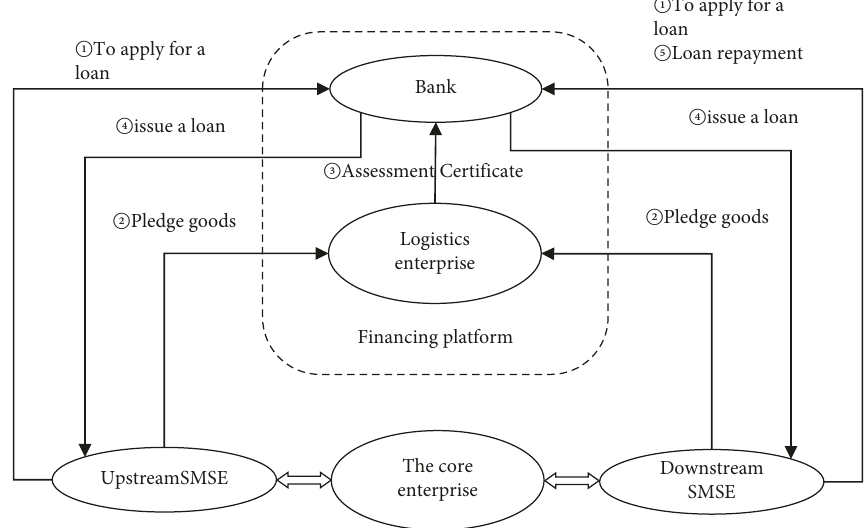
Figure 1: Financing flowchart of financing